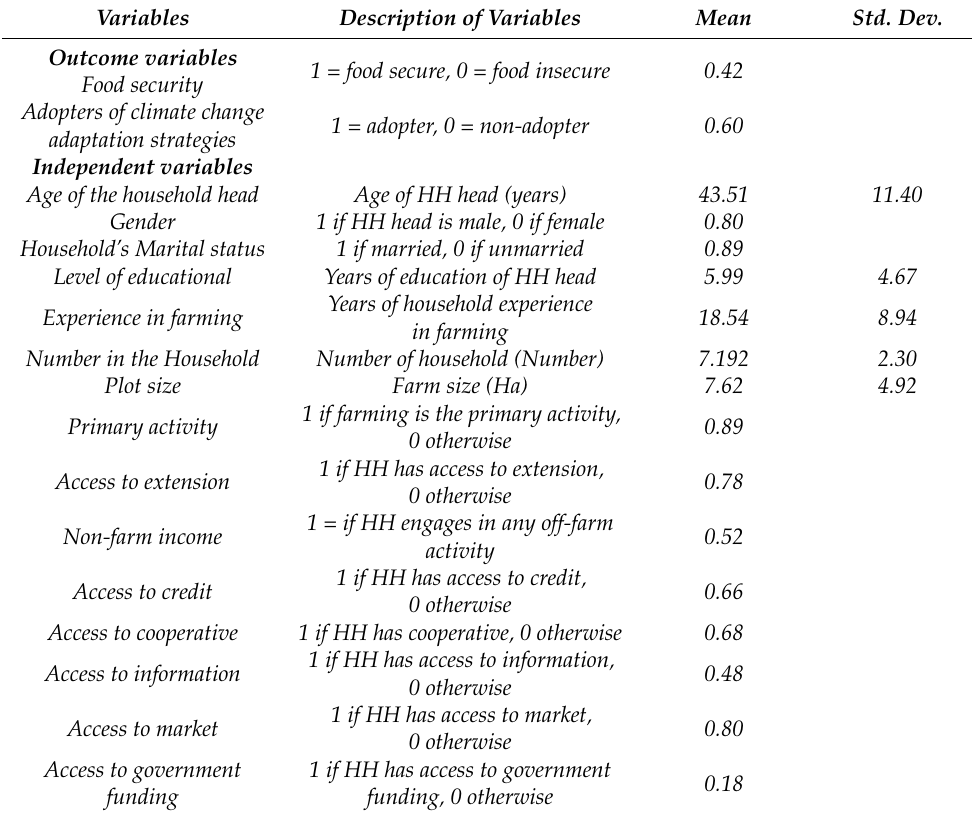
Table 1. Definitions and summary statistics of variables used in the